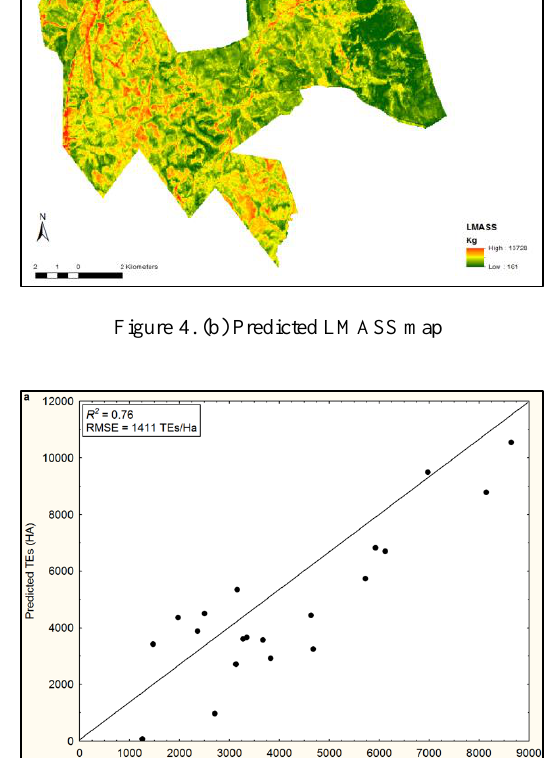
Figure 3. (b) VIP variables for LMASS. The red line indicates the VIP cut off value of 1. All predictors above the red line are significant in the model